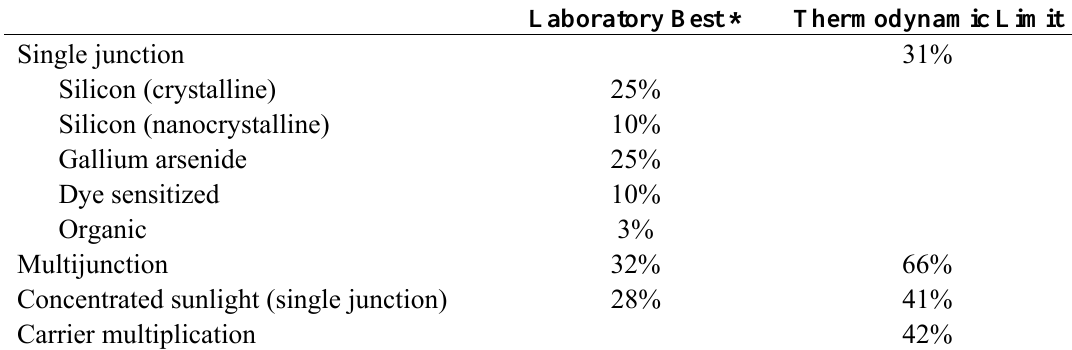
Table 1. Solar energy conversion efficiencies